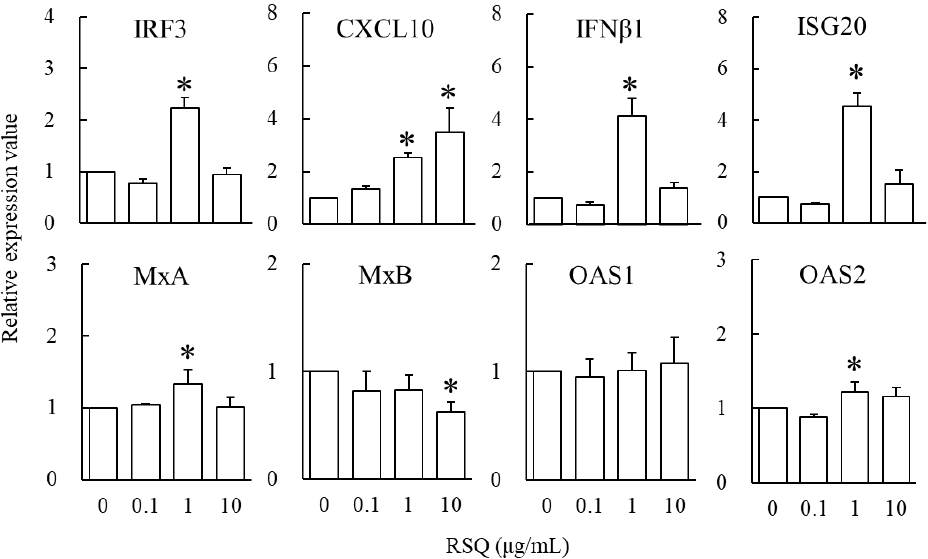
Figure 3. Effects of resiquimod (RSQ) on the expression of antiviral factor genes in M1-phenotype macrophages. M1-phenotype macrophages were cultivated in the presence of RSQ (0–10 µ g/mL) for 3 h. Quantitative real-time reverse transcription polymerase chain reaction assessed the relative expression values. The data are presented as the mean and SD ( n = 3). The comparison among multiple groups was evaluated using Dunnett’s posttest following ANOVA. * p < 0.05 ( vs. 0 μg/mL RSQ).